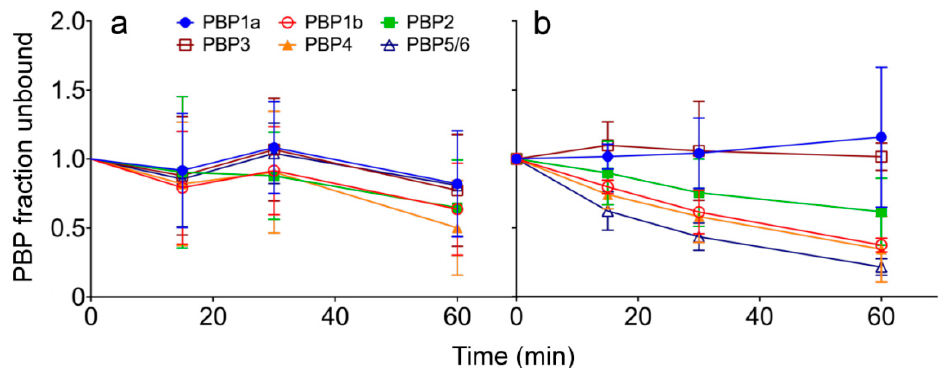
Figure 2. Time-course of intact cells and isolated PBP-binding assay. P. aeruginosa PAO1 cultures ( a ) and isolated PBP-containing membrane preparations ( b ) were incubated for 15, 30 and 60 min in the presence of 4 µg/mL avibactam (AVI). After isolating PBP-containing membranes, preparations were labeled with 25 µM bocillin FL. The graphs represent the PBP fraction unbound relative to each time control over time. The mean PBP fraction unbound values from at least three independent experiments ± standard deviations are shown.